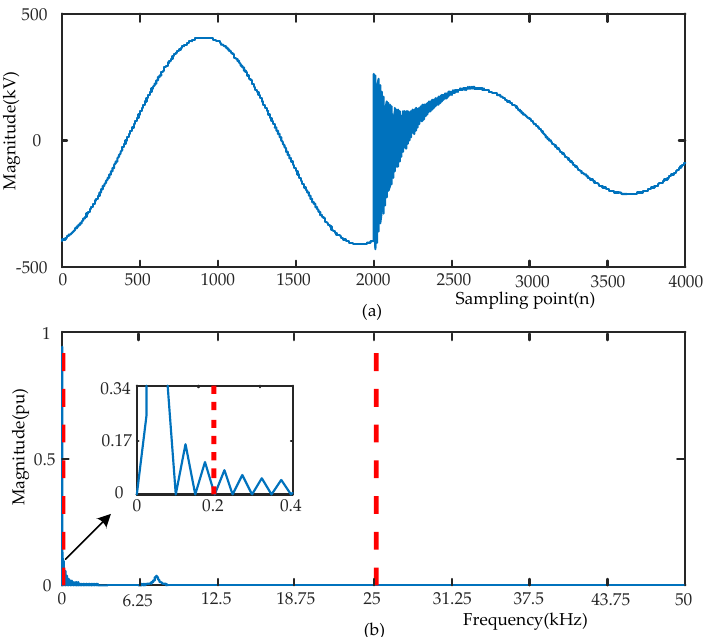
Figure 3. The signal of f ( n ) and Fourier spectrum with detected boundaries are listed as follows: ( a ) voltage signal; ( b ) detected Fourier supports for signal. Secondly, a low-pass filter and two band-pass filters are defined based on the above segmentation boundary. The Fourier transformation expressions of the scaling function ˆ φ 1 ( ω ) , i = 1 and the empirical wavelet function ˆ ψ i ( ω ) , i = 2, 3 are respectively given